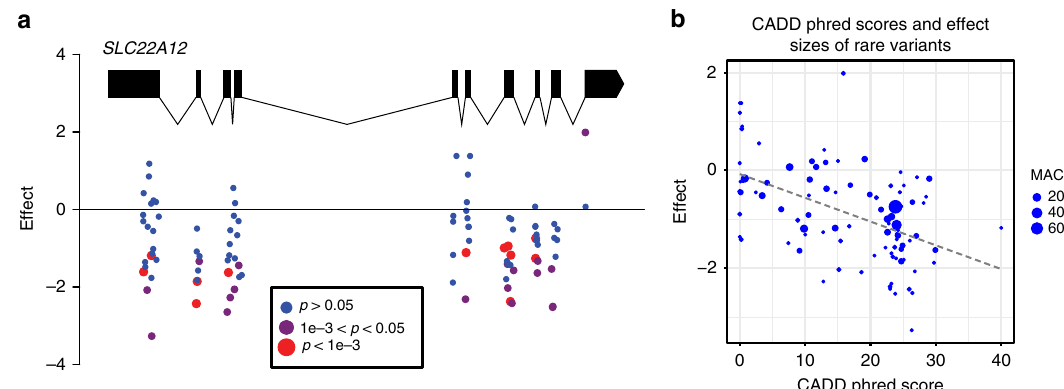
Fig. 1 Rare putative damaging variants in SLC22A12 . a Scheme of the transcript variant 1 (NM_144585.3) onto which positions of each putatively damaging variant included in the SLC22A12 gene-based tests were mapped. Marker color re fl ects the association p -value with serum urate from the single-variant primary meta-analysis; b higher CADD phred score was signi fi cantly associated with larger negative effects on serum urate among the rare variants (beta = − 0.05 per unit of CADD score, SE = 0.01, p = 2.3e-7)